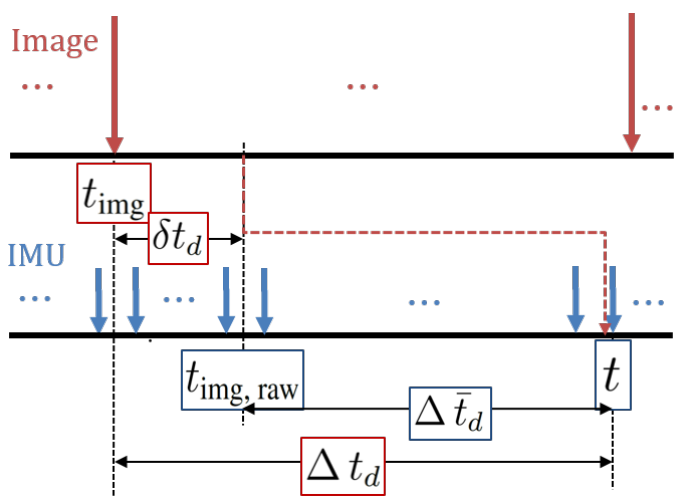
Figure 2. Data streams of the IMU and the delayed vision